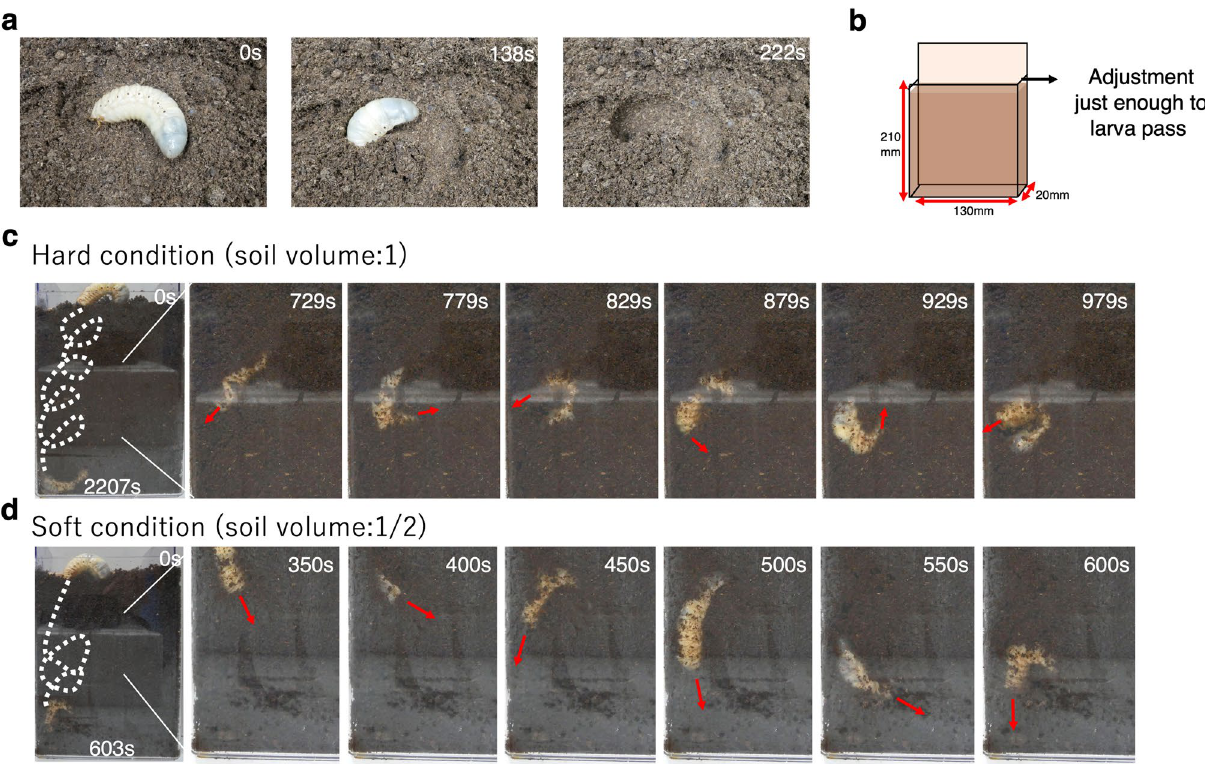
Figure 1. Burrowing dynamics of scarab beetle ( Trypoxylus dichotomus ) larva. ( a ) Burrowing images. After beetle is put on the soil, they can burrow in a short time (< 4 min). ( b ) A schematic of the pseudo- two dimensional (2D) observation tank. The depth was adjusted just enough for larva to pass. ( c ) Pseudo 2D observation image, before and after burrowing, and during burrowing. ( d ) The dynamics of burrowing in soft sediment [half volume soil compared to ( c